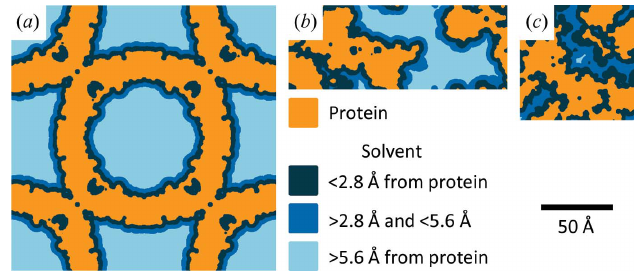
Figure 2 Solvent-cavity structure in ( a ) cubic apoferritin, ( b ) tetragonal thaumatin and ( c ) tetragonal lysozyme crystals at room temperature. The van der Waals surface of the protein is shown in orange. Solvent spaces within the first and second hydration shells are shown in dark blue and medium blue, respectively. Supplementary Movies S1–S6 provide detailed views of the protein and solvent-cavity structures.